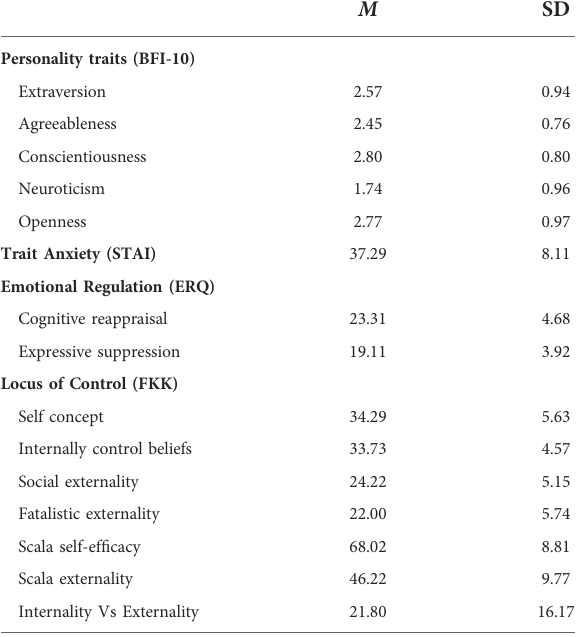
TABLE 1 Descriptive characteristics: questionnaire raw